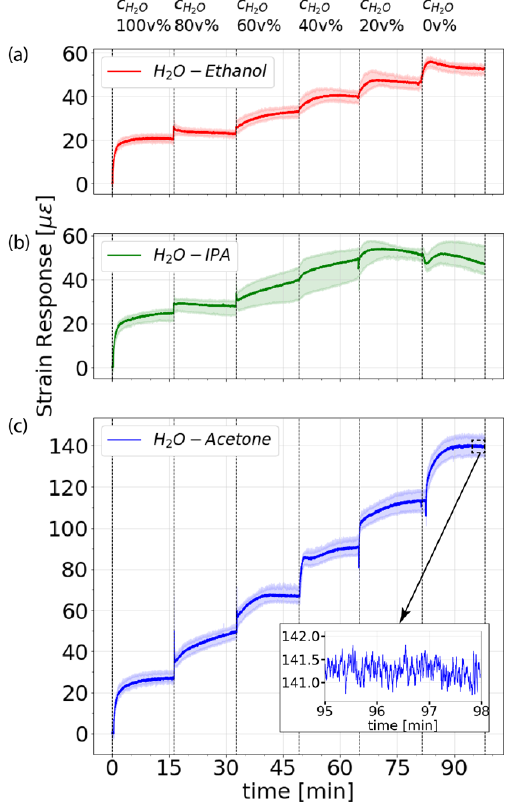
Figure 4. Temporal evolution of the swelling-induced strain for the three baths containing ( a ) ethanol, ( b ) IPA, and ( c ) acetone in water. The solid lines show the average values for the immersed sections. The colored regions depict the entire strain range measured at the different fiber positions. The inset graph shows the last three minutes of the strain response for acetone, highlighting the low measurement noise of the system.